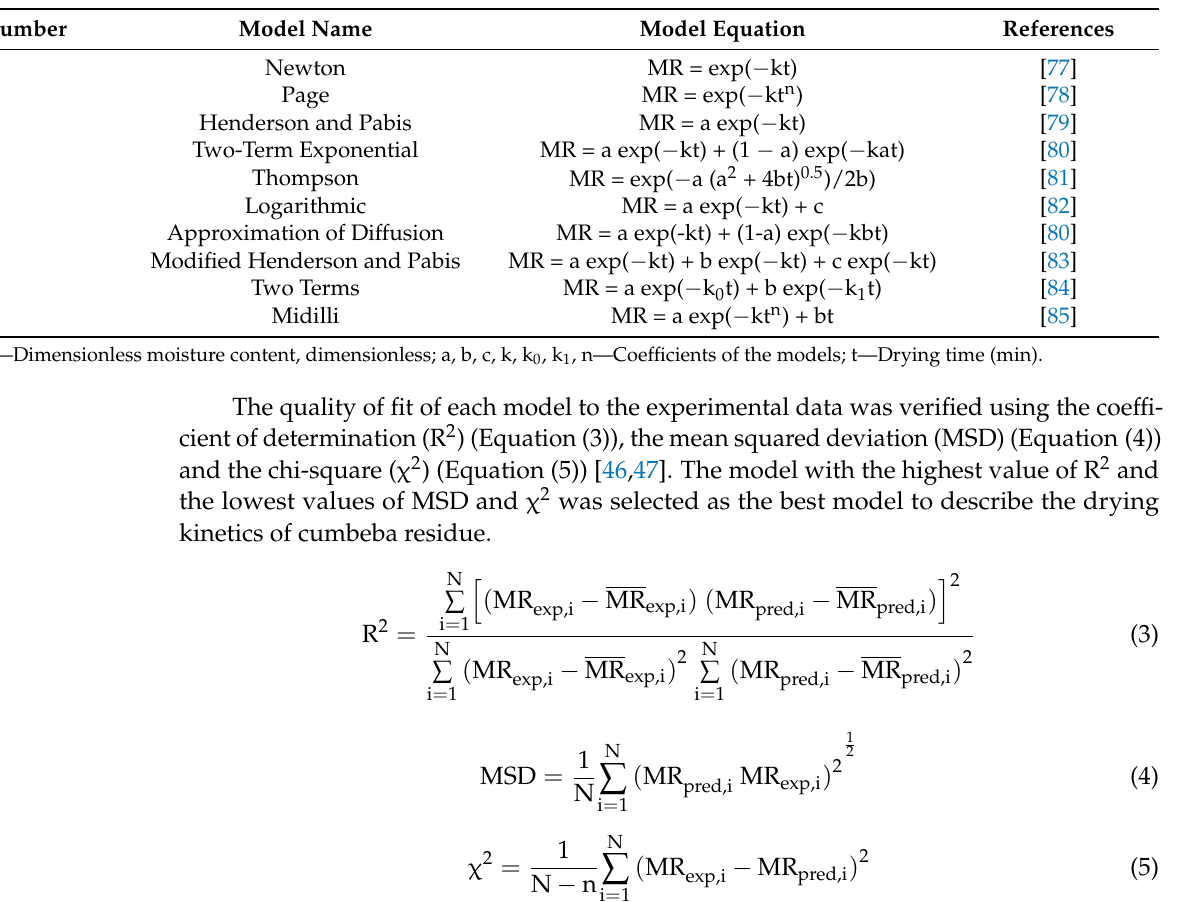
Table 1. Models fitted to the drying kinetic curves of cumbeba